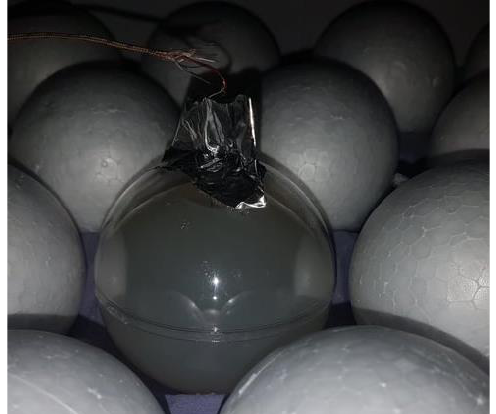
Figure 2. Example of an artificial fruit used in the experiment.